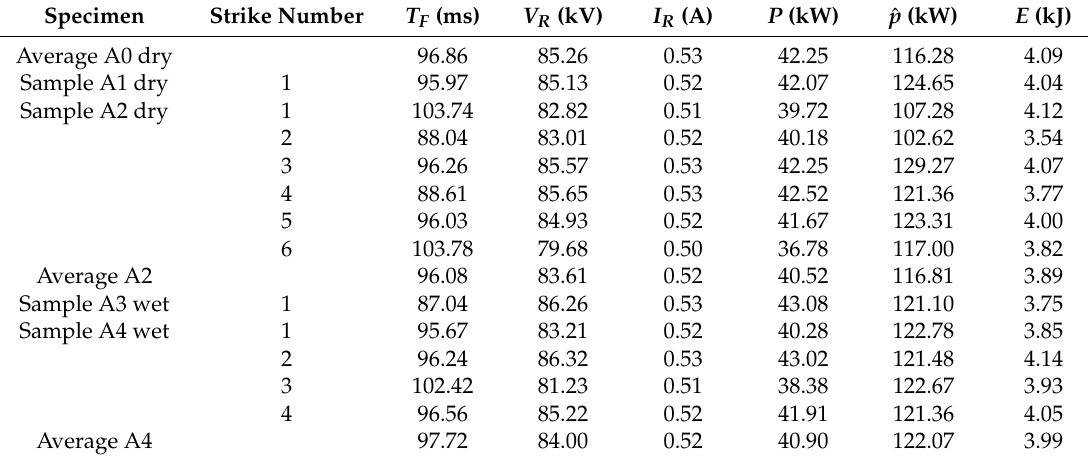
Table 2. Summary of the electrical data for each strike on sample A. Legend: T F = fault duration; V R = root mean square (RMS) voltage during the fault; I R = RMS current during the fault; P = mean fault power; ˆ p = peak instantaneous power; E = total fault power;